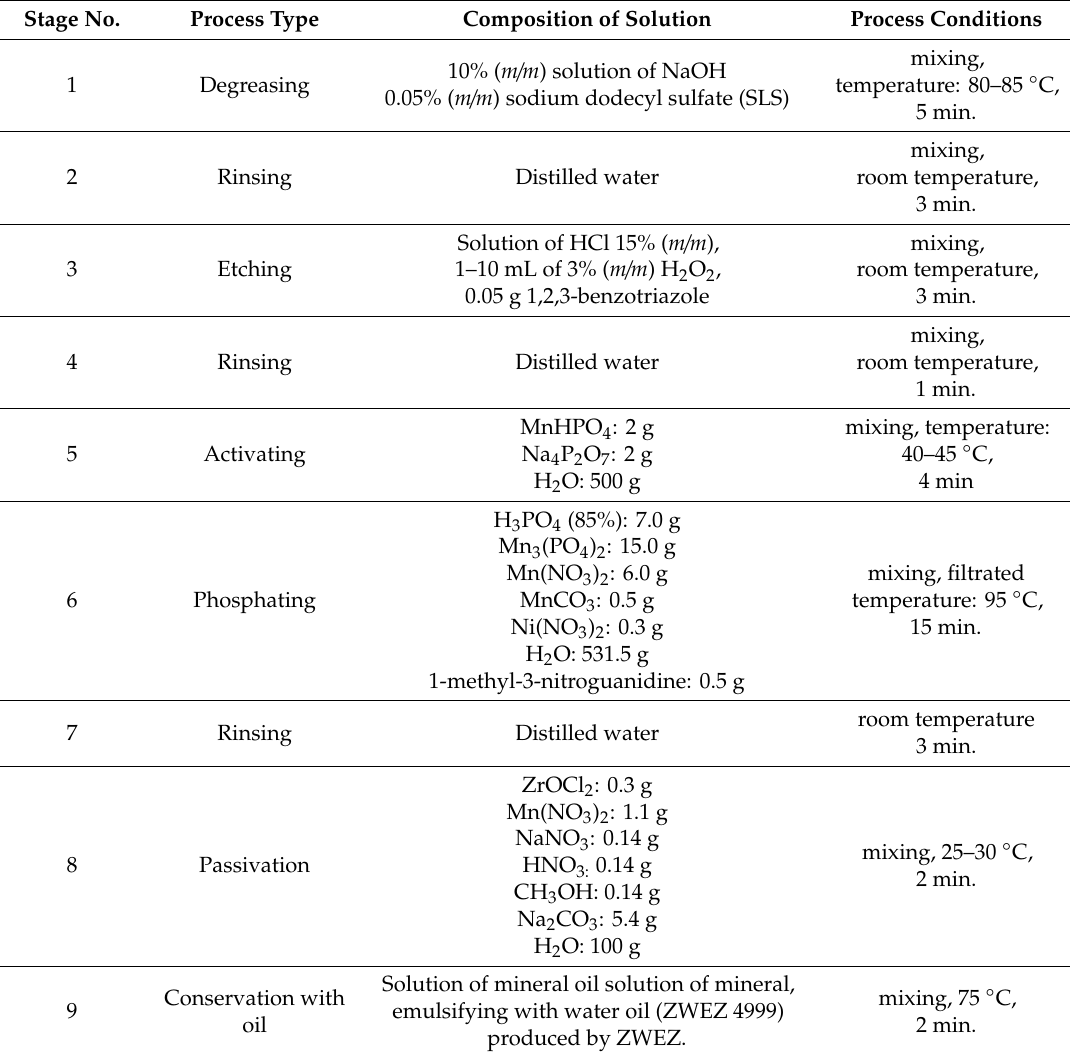
Table 2. Quantitative composition of the proposed standard baths complete with stages [8]. Stage